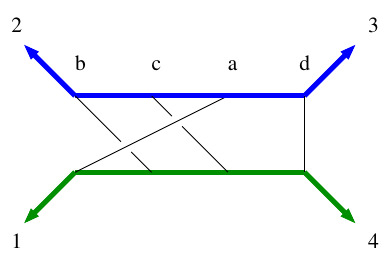
Figure 7 . Crossed-ladder diagram corresponding to the integral I (lad)